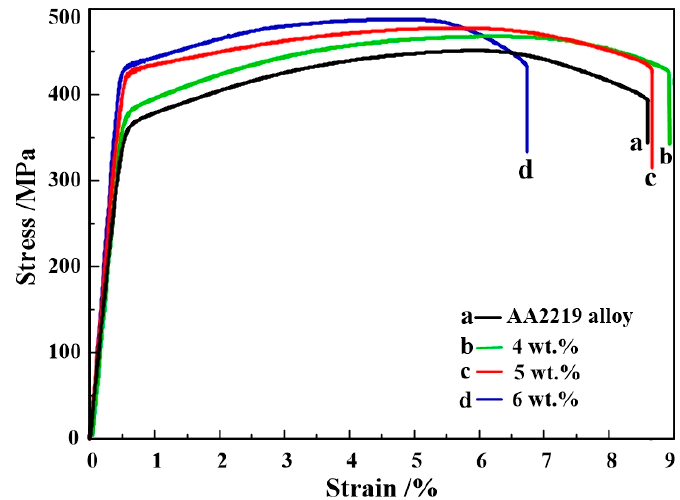
Figure 7. Engineering stress–strain curves of AA2219 alloy and the present composites.